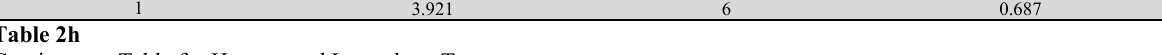
Contingency Table for Hosmer and Lemeshow Test